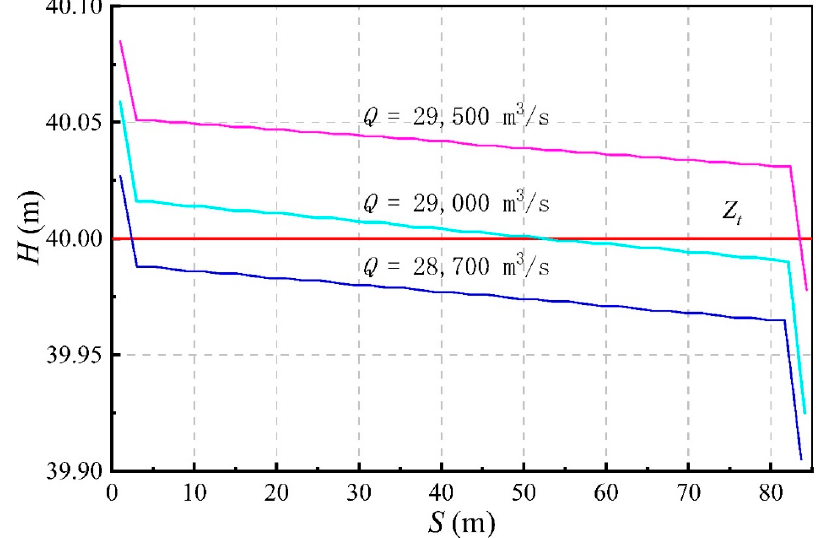
Figure 10. Water head of discharge low hole for transition flow.